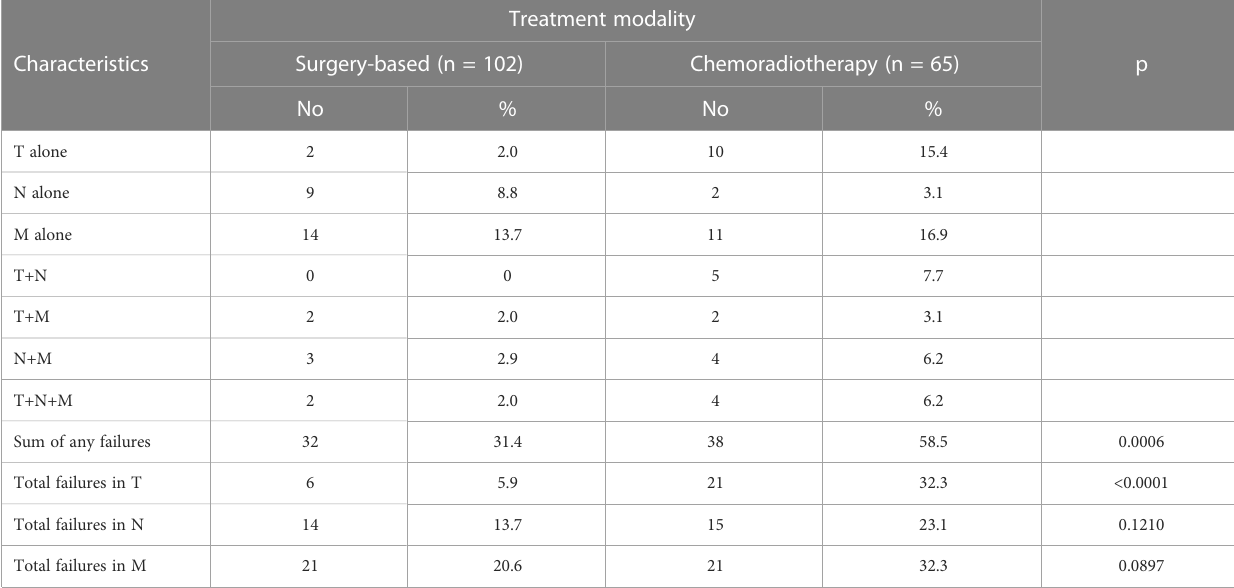
TABLE 2 Patterns of